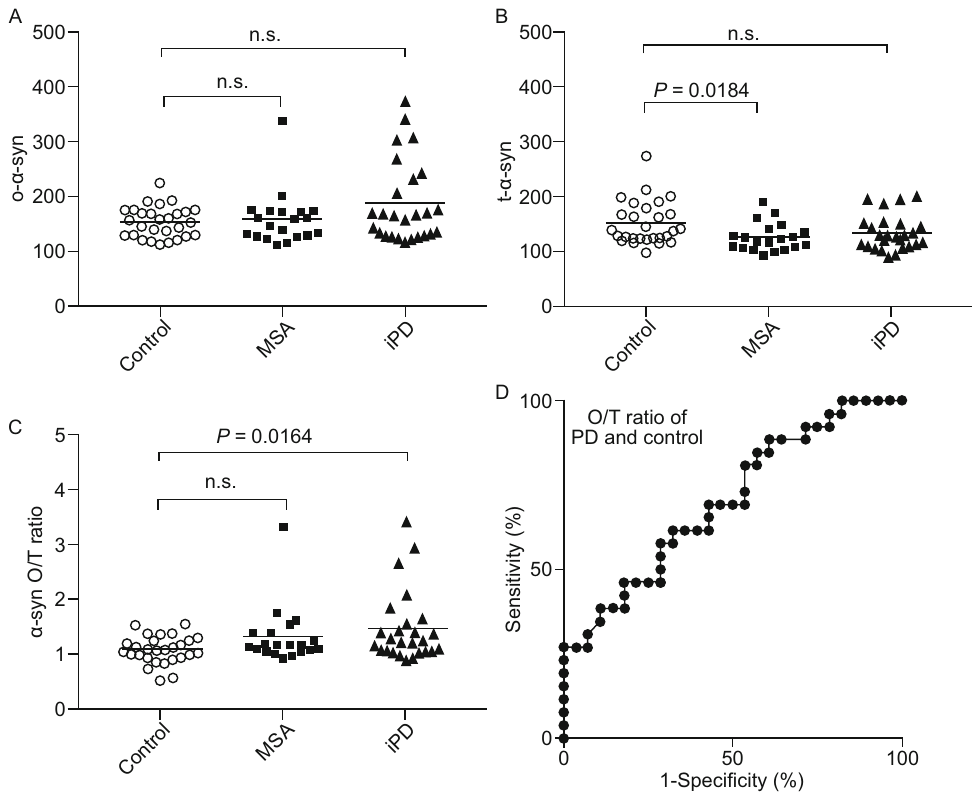
Figure 2. AlphaLISA assays detection of CSF α -syn in human patients . (A) Comparison of the oligomer α -syn between PD, MSA, and control patients. (B) Comparison of the total α -syn between PD, MSA, and control patients. (C) Comparison of the O/T ratio between PD, MSA, and control patients. (D) Receiver operating curves (ROC) for the levels of O/T in the patients tested CSF. All PD and control patients were concluded for ROC analysis, the area under curve (AUC) = 0.701. For Figure 2A – C, scatterplots representing individual sample values (means of 3 technical replicates). Each bar represents the mean value. PD = Parkinson ’ s disease, MSA = multiple system